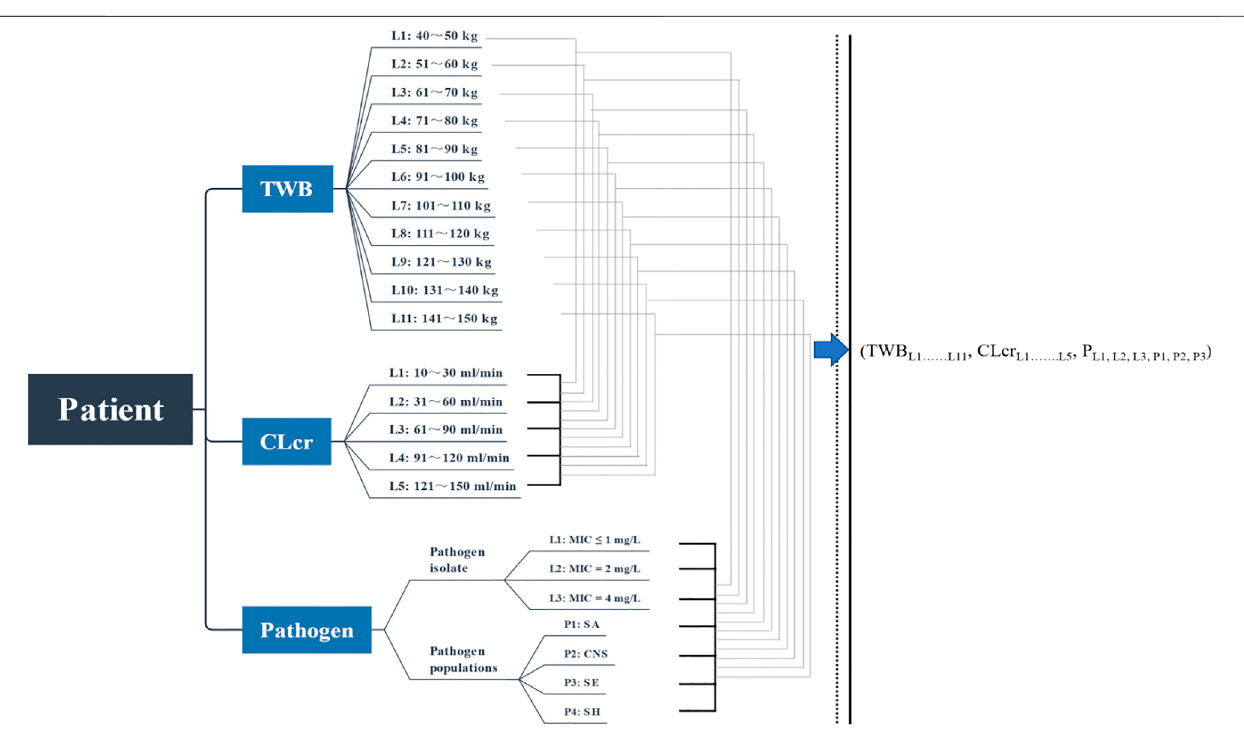
Frontiers in Pharmacology |